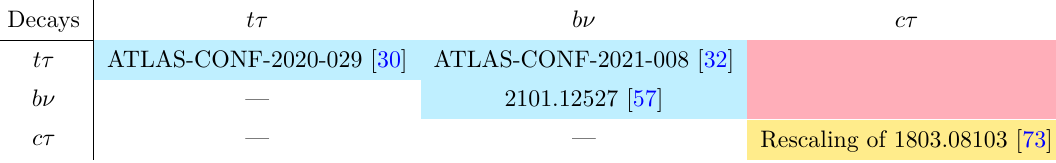
Table 3 . SM final states originating from leptoquark pair production and decay, provided together with their coverage by the LHC searches considered in this work. The first (second) leptoquark decay is indicated by the row (column) of the table, and the colour code shows the relevance of the signatures for the BS1 (blue) and BS2 (yellow) benchmarks. Signatures appearing in red are currently not covered